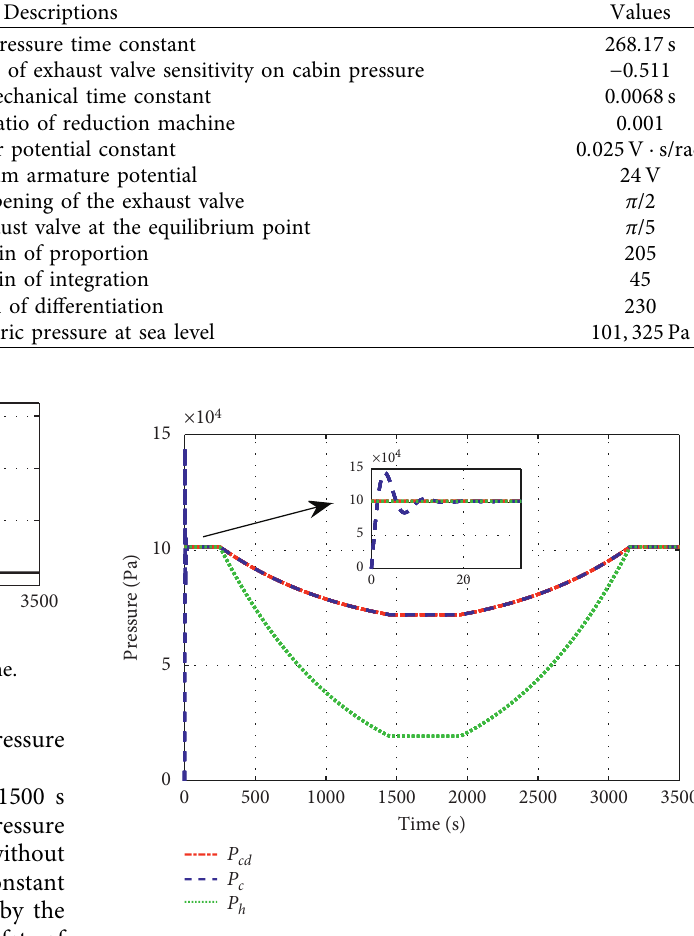
Figure 5: Pressure response of CPCS in the entire flight envelope.